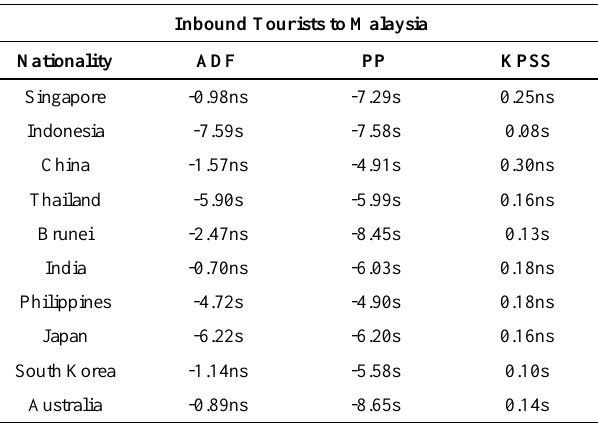
Table 5. Results of Unit Root Tests.